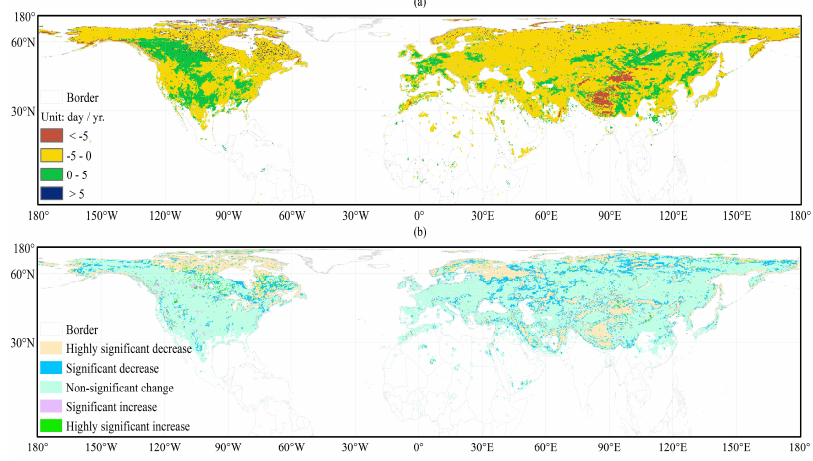
Figure 10. ( a ) The variation rate of the snow cover days (SCD) and ( b ) variation trend grades of SCD over the Northern Hemisphere from 1992–2016. over the Northern Hemisphere from